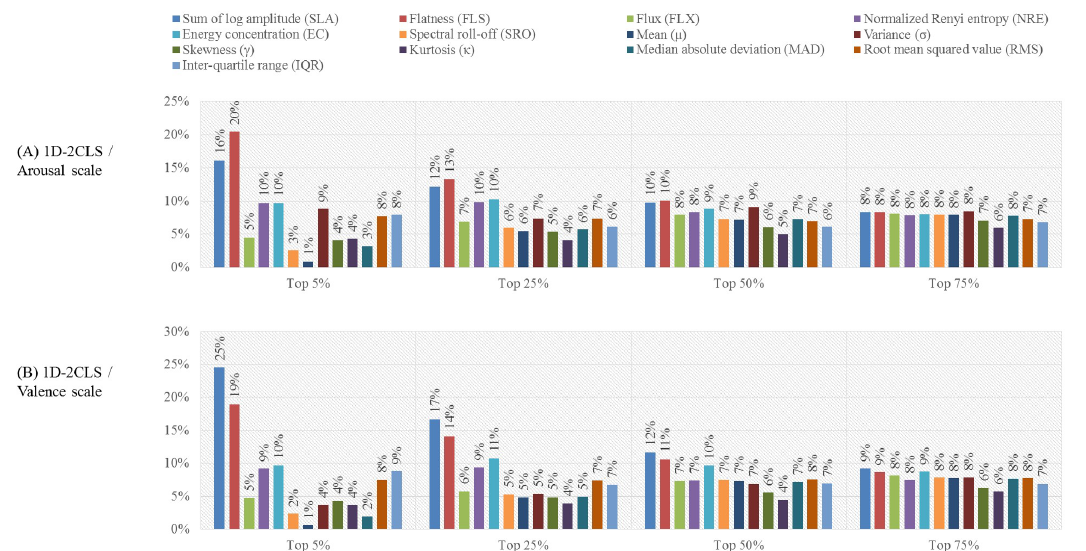
Figure 4. The ratio between the number of times each time-frequency feature is selected to the total number of selected features computed for each of the four feature selection scenarios. ( A ) presents the computed percentages for the 1D-2CLS using the arousal scale, and ( B ) presents the computed percentages for the 1D-2CLS using the valence scale.